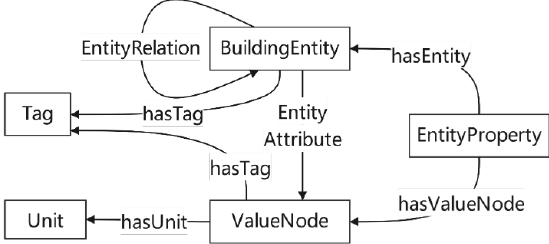
Figure 2. Top schema of the clause-entity knowledge graph.